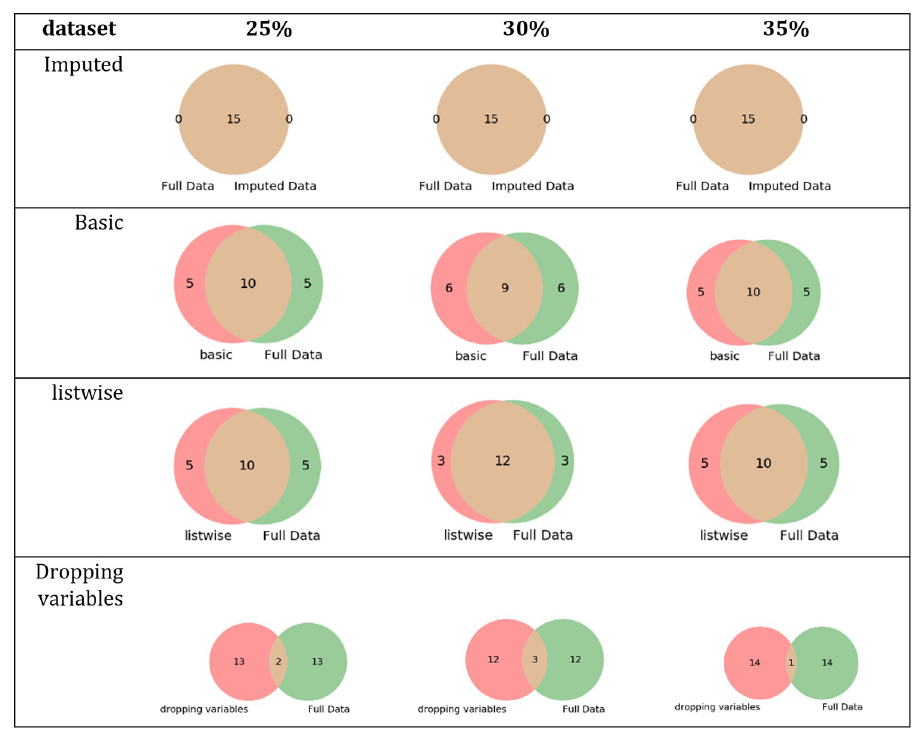
Fig 8. Intersections of sets of relevant features of the letter-recognition dataset and its simulated datasets.